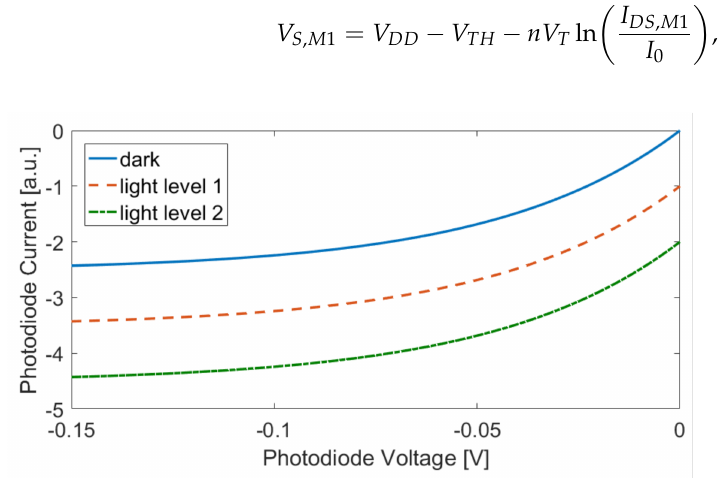
Figure 1. Simulated I-V characteristic of the photodiode for increasing levels of light. The photodiode current is expressed in arbitrary units (a.u.).